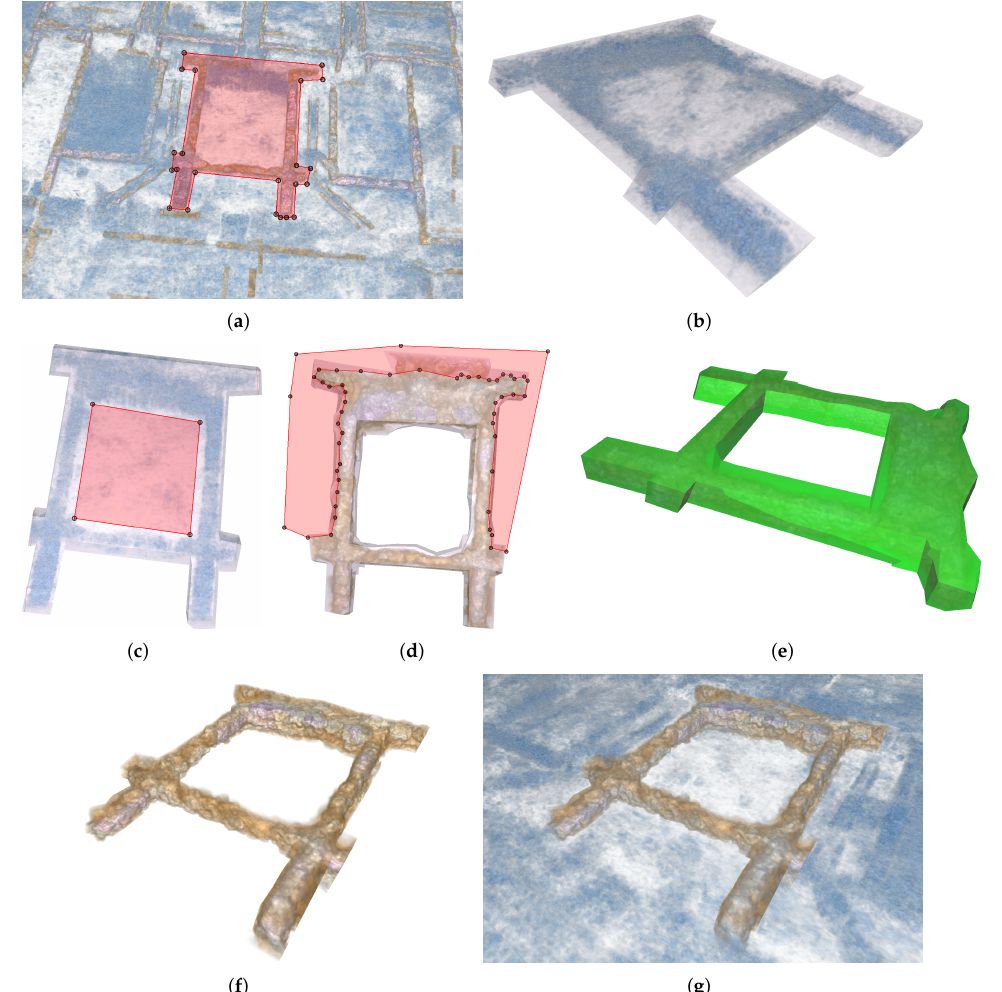
Figure 18. Interactive 3D GPR interpretation by polygon extrusion and CSG operations: Initial 2D contour ( a ). Visualization limiting DVR to the interior of the extruded 3D model ( b ). More 2D contours ( c , d ) and refined 3D interpretation model obtained using difference operations ( e ). Final 3D model applied to TV-L1 filtered dataset. Details of the structure surface are visible from any viewing perspective ( f ). Highlighting of the interpreted wall in the surrounding data ( g